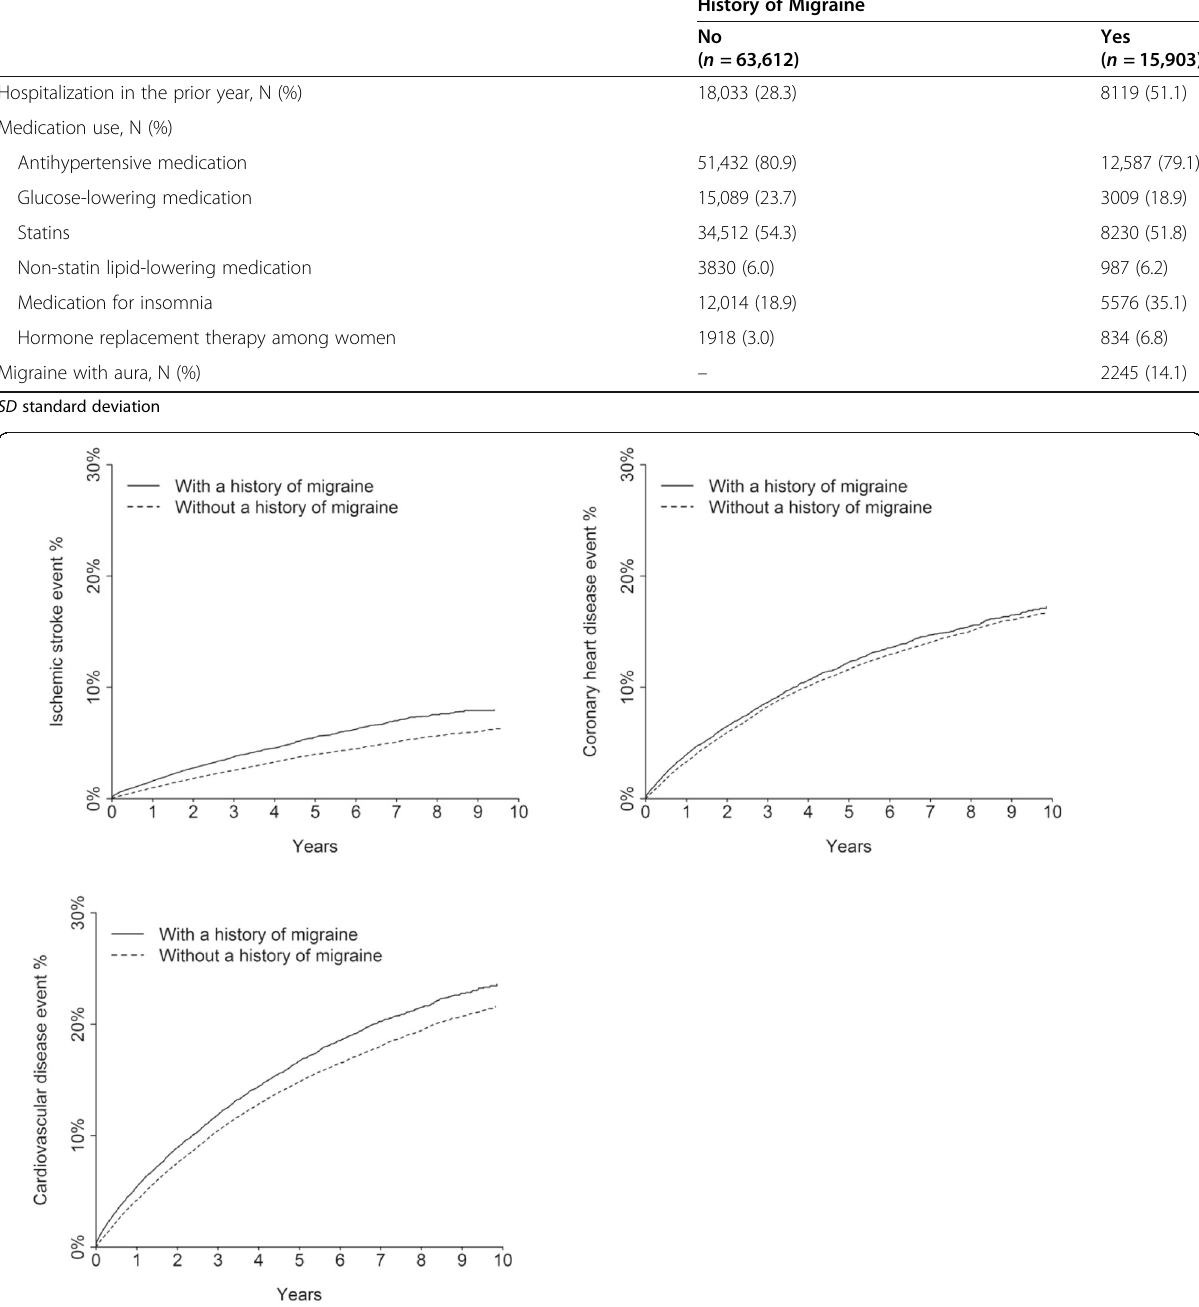
Table 3 Characteristics of patients with a history of cardiovascular disease who had and did not have a history of migraine (Continued)